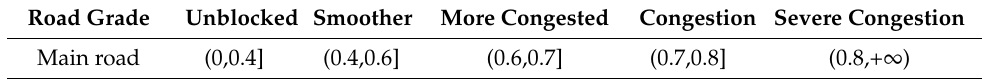
Table 3. Judgement criteria for road section saturation.